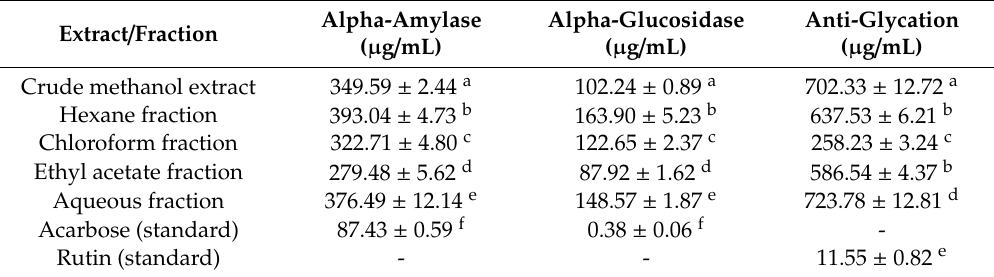
Table 3. IC 50 values exhibited by G. edulis methanol extract and methanol fractions against the inhibitory activity of the enzymes α -amylase and α -glucosidase and antiglycation